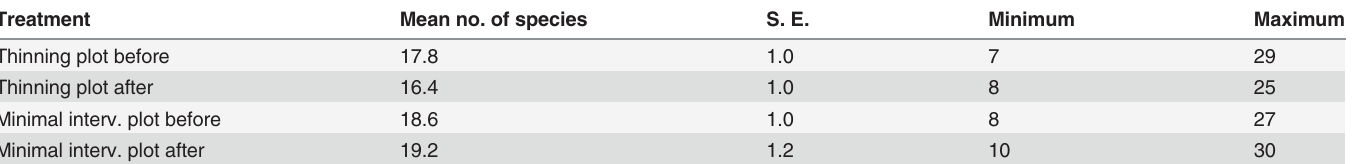
Table 2. Descriptive statistics for the number of species found on all sites (n =